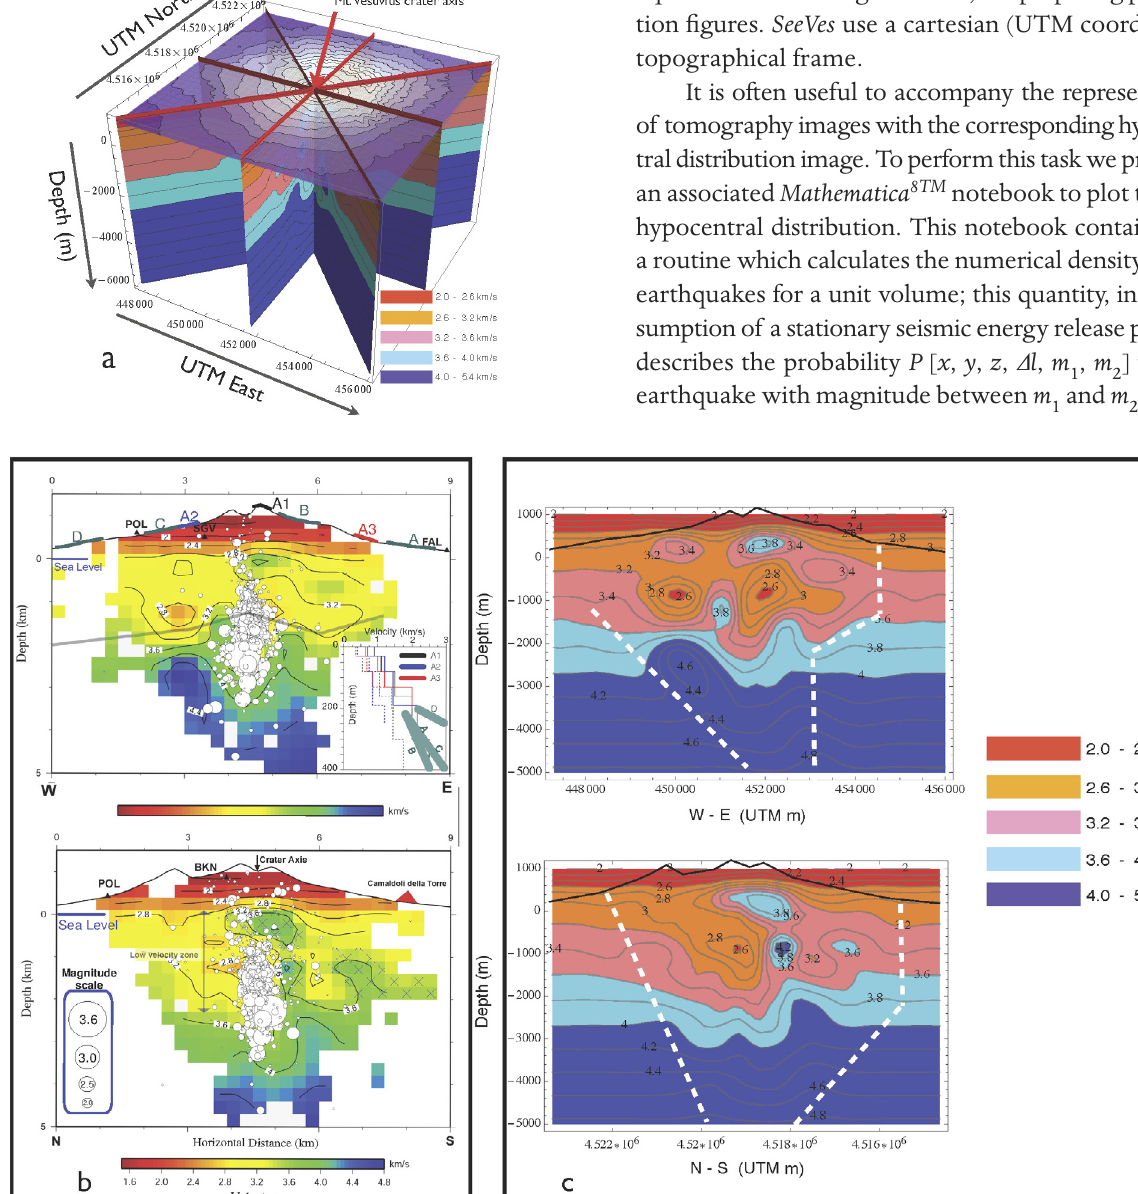
Figure 1. (a) 3D plot of interpolated Vp distribution in the earth volume below Mt. Vesuvius, centered at the crater axis. Easting and Northing is in UTM (meters). Depth is negative below the sea level. Mt. Vesuvius map is plotted in trasparency at 800 m a.s.l.; (b) W-E and N-S velocity sections redrawn from Scarpa et al. [2002]; (c) W-E and N-S velocity sections represented using SeeVes . Dashed line borders the resolved